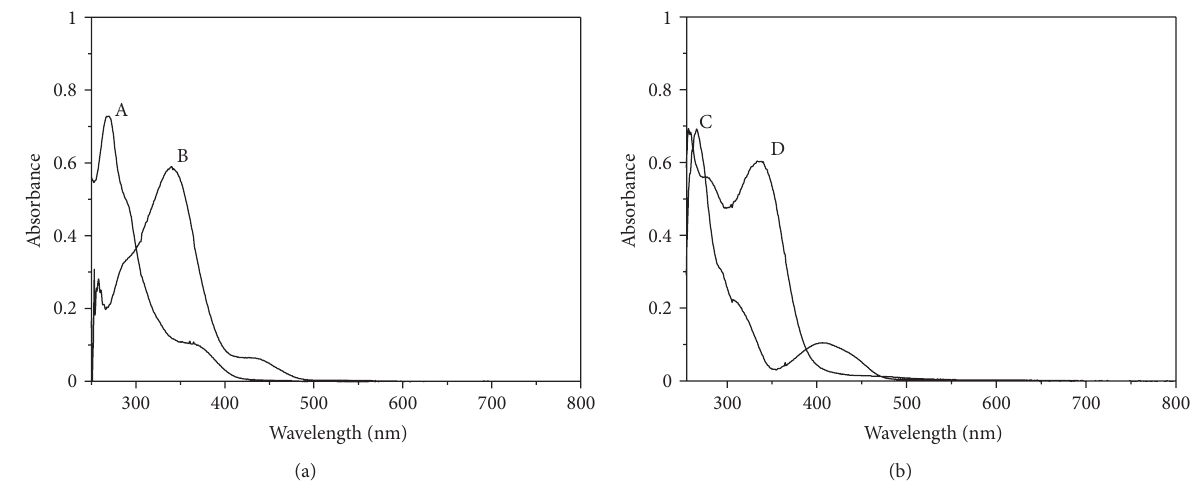
Figure 1: Absorption spectra of VO(msatsc)(phen) (A) and its ligand salsem (B) in (a) and VO(4-cholrobrsatsc)( phen ) (C) and its ligand 4-cholrobrsatsc (D) in (b), respectively.